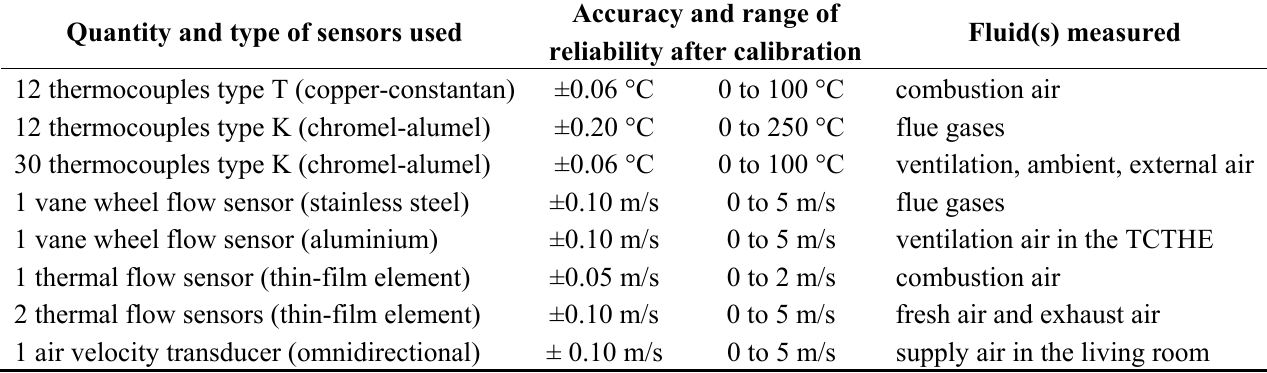
Table 1. Applications and characteristics of the temperature and flow sensors used on the experimental setup.